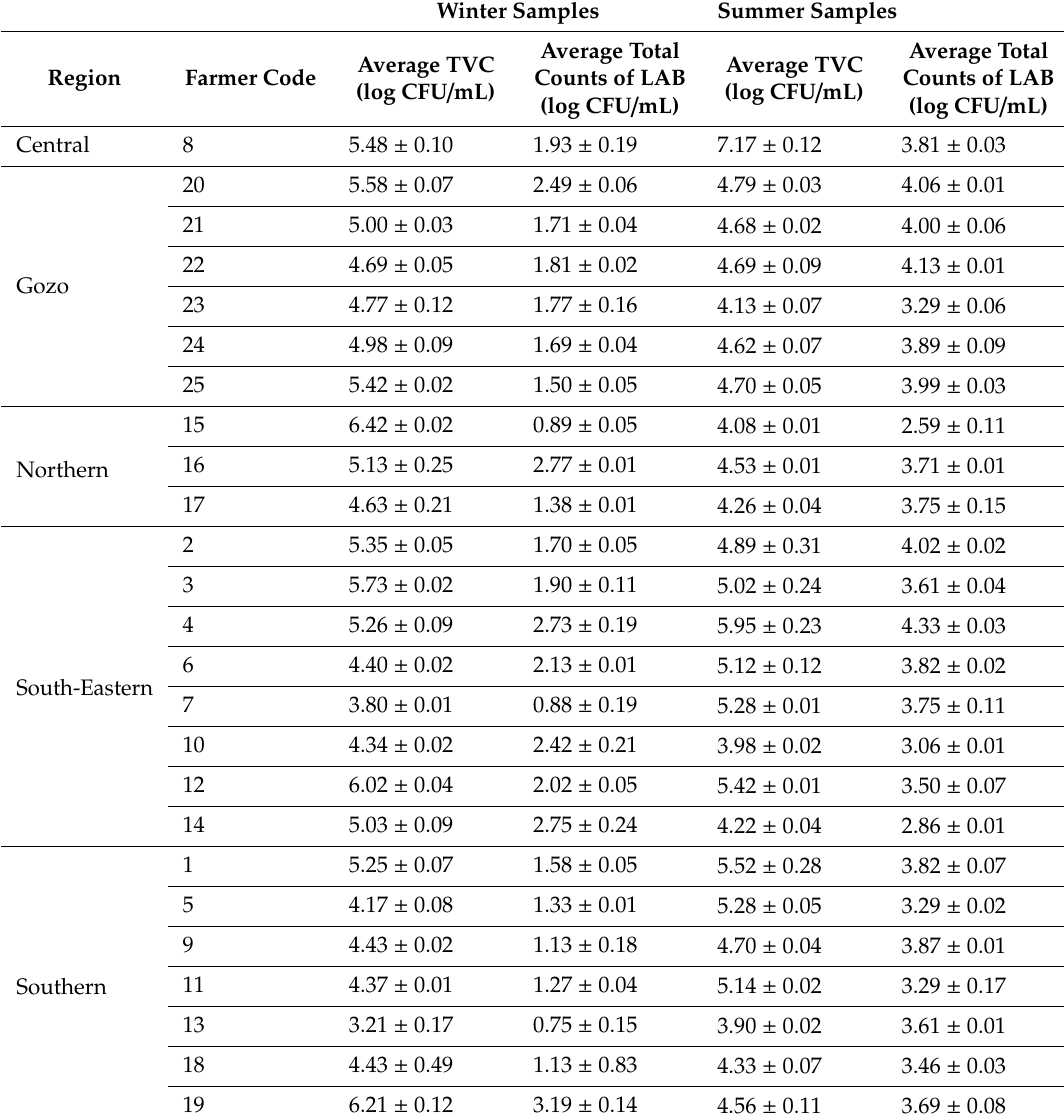
Table 1. The total viable counts (TVC) and lactic acid bacteria (LAB) population in both the winter (2015) and summer (2016) raw cow milk samples of Maltese